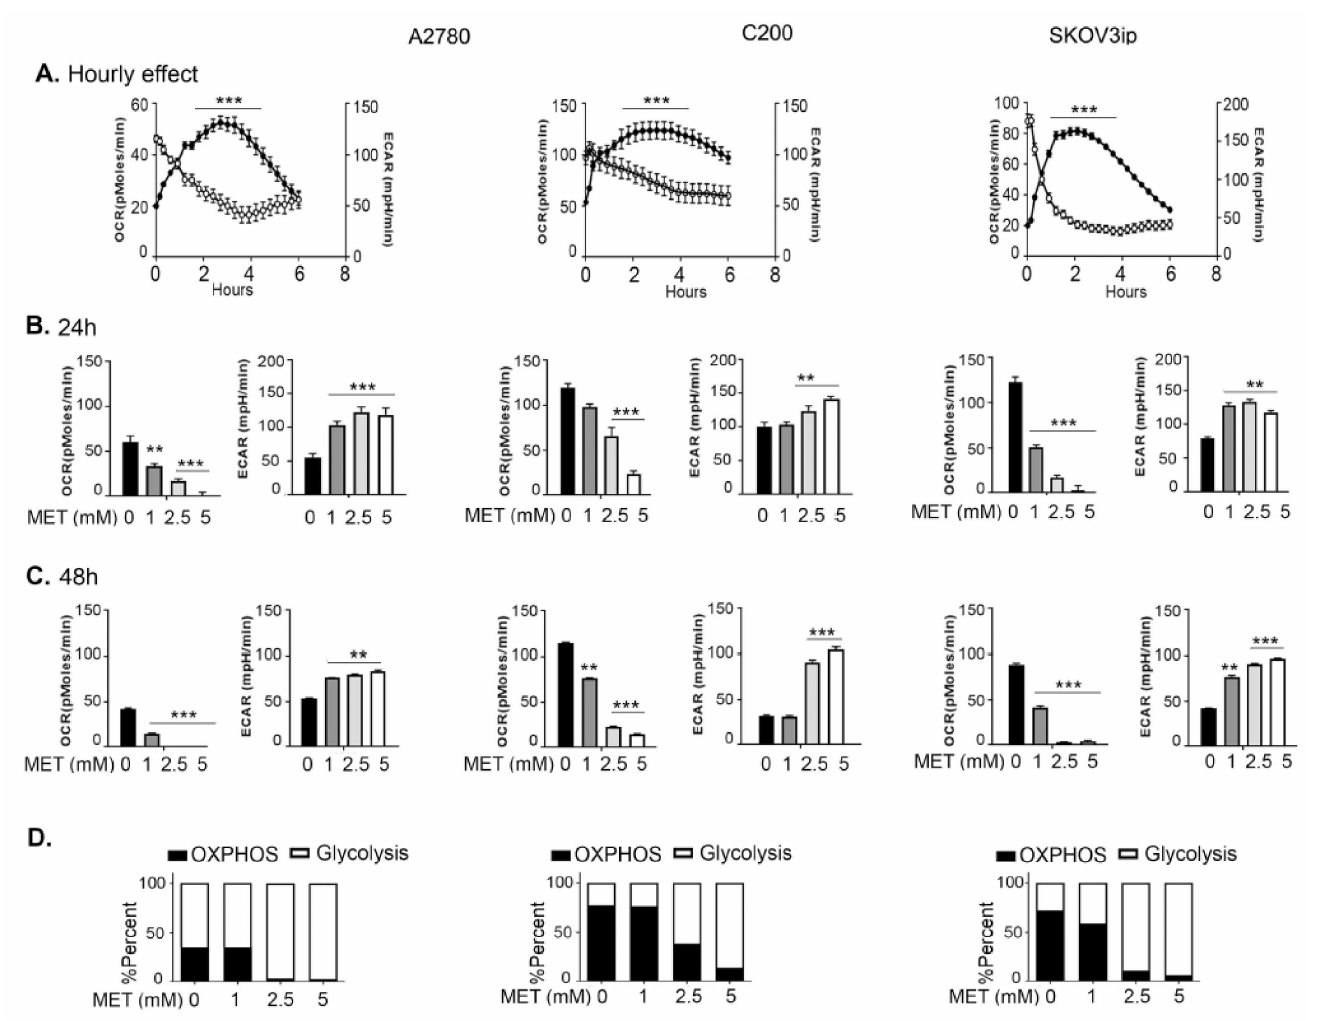
Figure 1. Metformin induces sustained effects on cellular bioenergetics. Cell lines were subjected to increasing metformin (MET) concentrations for increasing time periods and cellular bioenergetics were measured. Basal OCR (oxygen consumption rate) and ECAR (extracellular acidification rate) changes in A2780, C200, and SKOV3ip cells ( A ) after immediate 5 mM metformin exposure, open circles represent OCR and closed circles represent ECAR; ( B ) after 24 h of indicated metformin exposure; ( C ) after 48 h of indicated metformin exposure. ( D ) Bioenergetic profile of the cell lines representing the percent ratio of OCR and ECAR being conducted by each cell line at 24 h of indicated metformin exposure. For all graphs, ** p ≤ 0.01, and *** p ≤ 0.001, metformin treated compared to